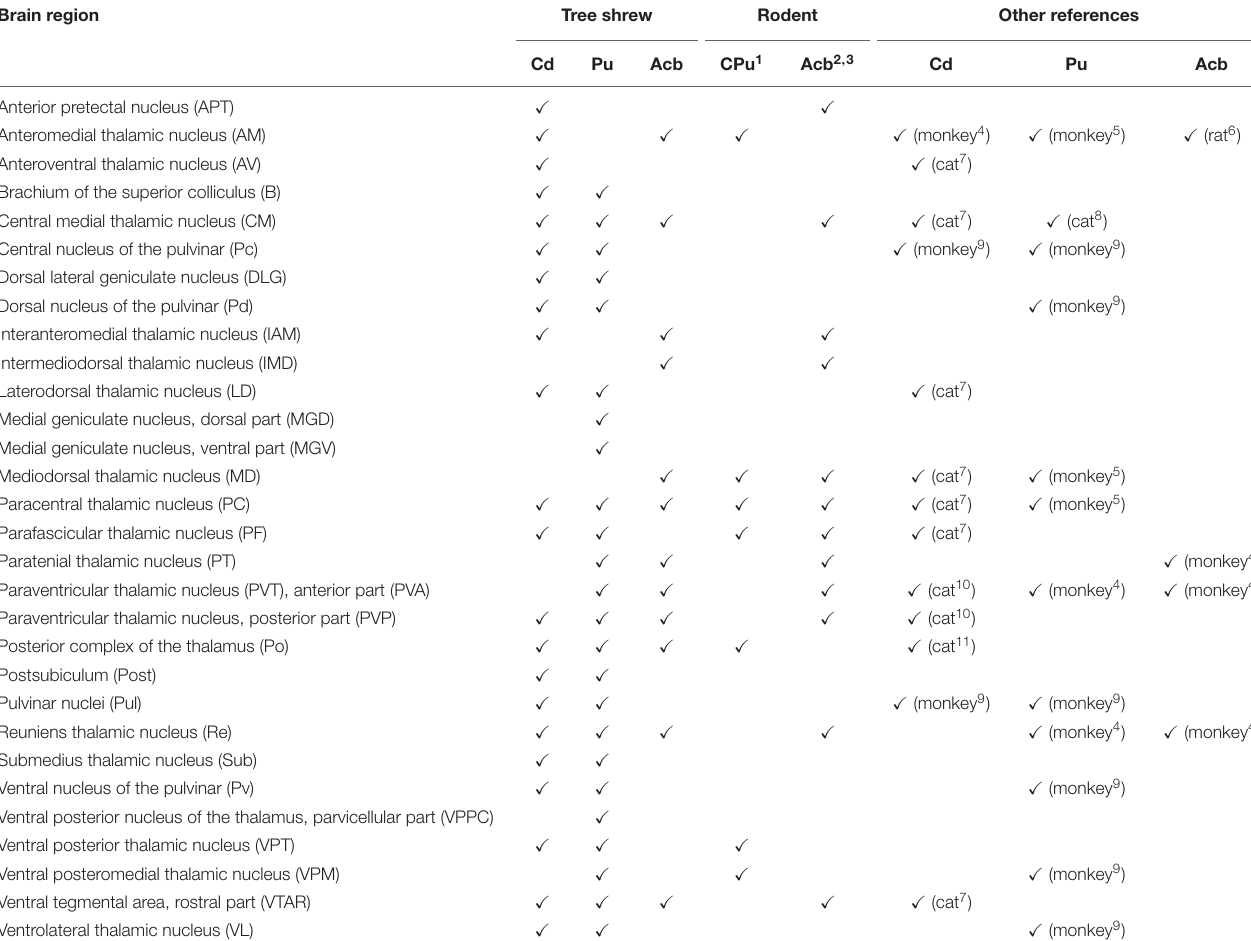
TABLE 1 | Comparison of thalamic inputs into the striatal subregions of tree shrews (present study) with those of other animals (for detailed comparison of whole-brain inputs and complete data, see Supplementary Table 1 ). Brain region Tree shrew